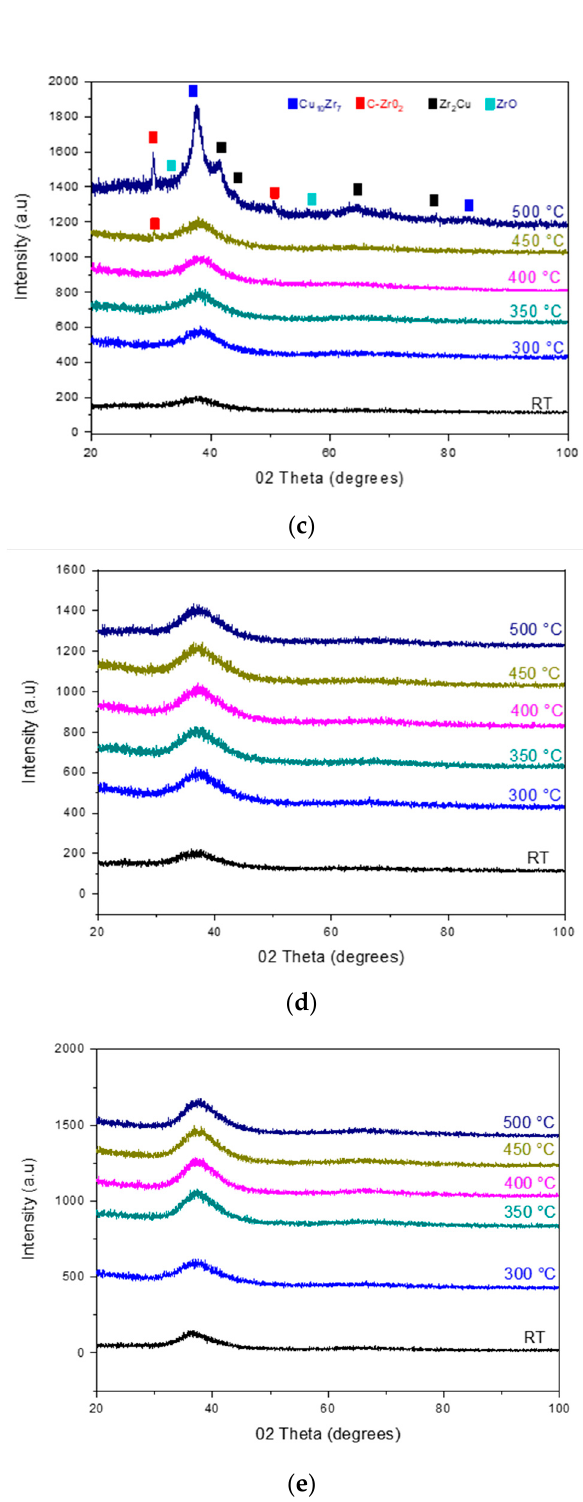
Figure 7. XRD patterns of Ta-free TFGM, ( a ) without Ta, ( b ) 18 at % Ta, ( c ) 21 at % of Ta, ( d ) 31 at % of Ta, and ( e ) 47 at % of Ta, annealed at different temperatures.